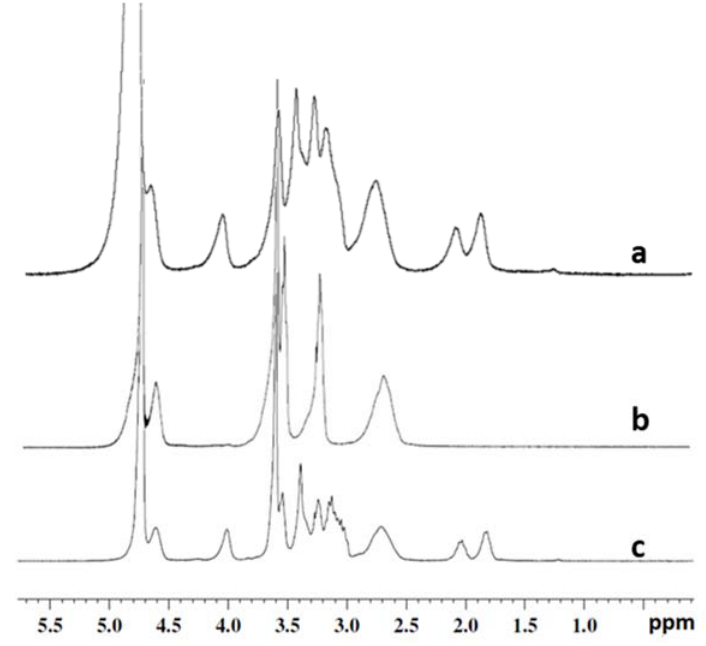
Figure 8. The typical 1 H ‐ NMR spectrum of a ) PHEA ‐ g ‐ bAPAE (D 2 O at pD < 5), b ) PHEA ‐ g ‐ PEG(C) (D 2 O), and c ) PHEA ‐ g ‐ PEG(C) ‐ g ‐ bAPAE (D 2 O at pD < 5).